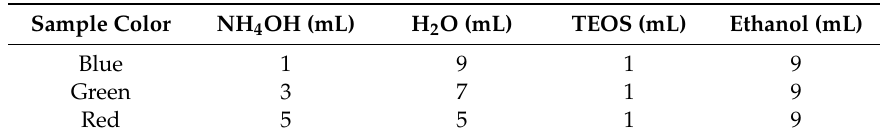
Table 1. Precursor quantities of silica nanoparticle fabrication used to produce various structural color